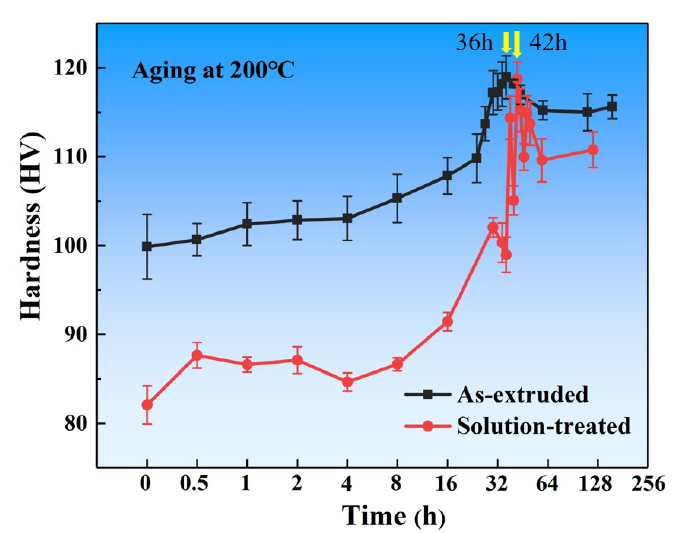
Figure 2. The hardness evolutions at aging temperature of 200 °C for the as-extruded and solution- treated Mg-11.46Gd-4.08Y-2.09Zn-0.56Zr